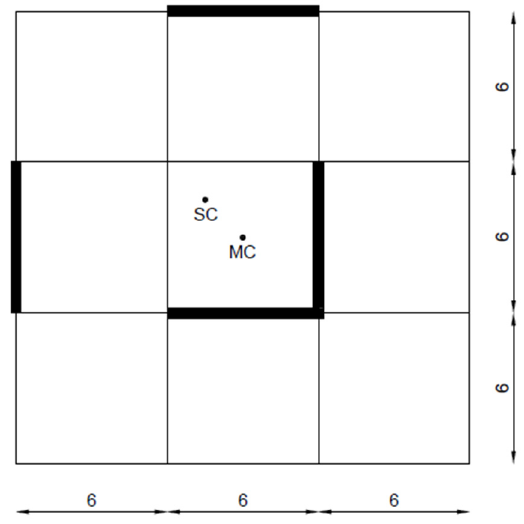
Figure 15. Plan of the one-floor building with the non-symmetrical CBF configuration (case studies 3 and 4).